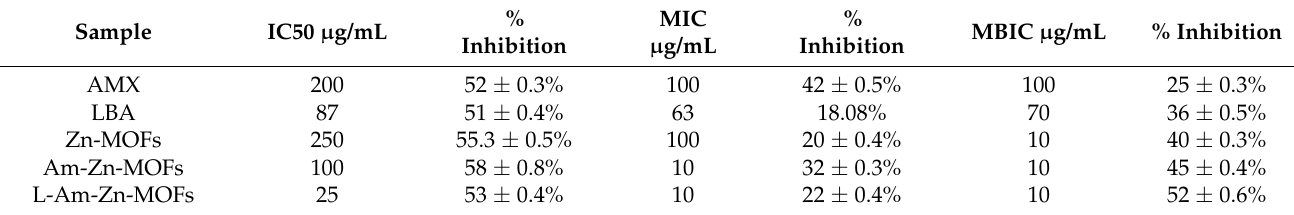
Table 2. IC 50 , MIC, and MBIC values of AMX against H. pylori